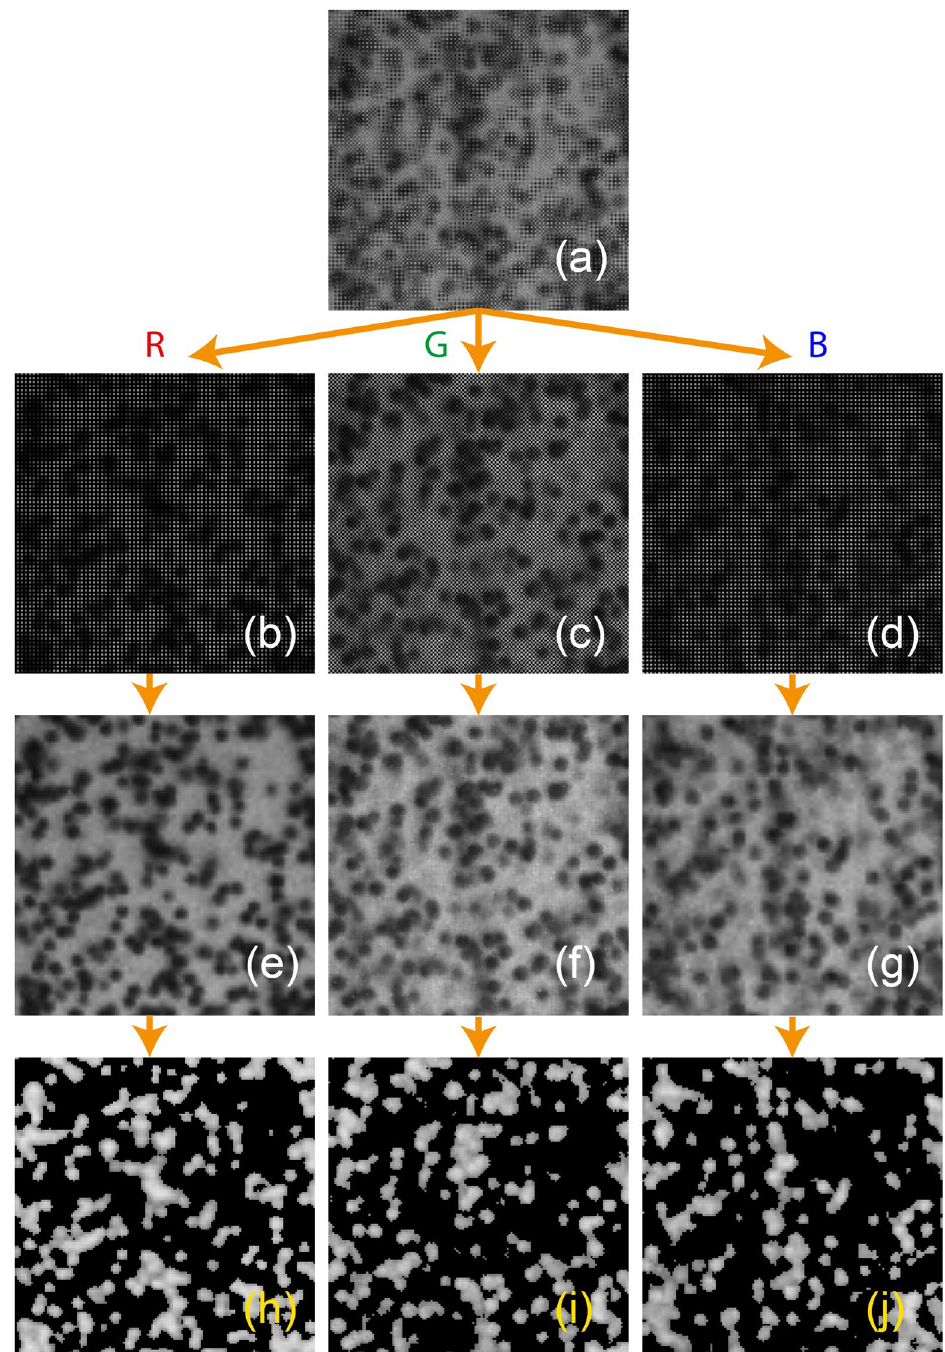
Figure 10. Steps for preprocessing of the raw image file, showing the same region as in Fig. 9(b). ( a ) The raw image from the Bayer filter array in gray-scale intensity. ( b – d ) Separation of the color channels based on pixel location in the array, with other pixels filled by zeros. ( e – f ) Resulting images after demosaic interpolation (Malvar et al . 29 ). ( h – j ) Final images for each color after background subtraction and filtering by local standard deviation